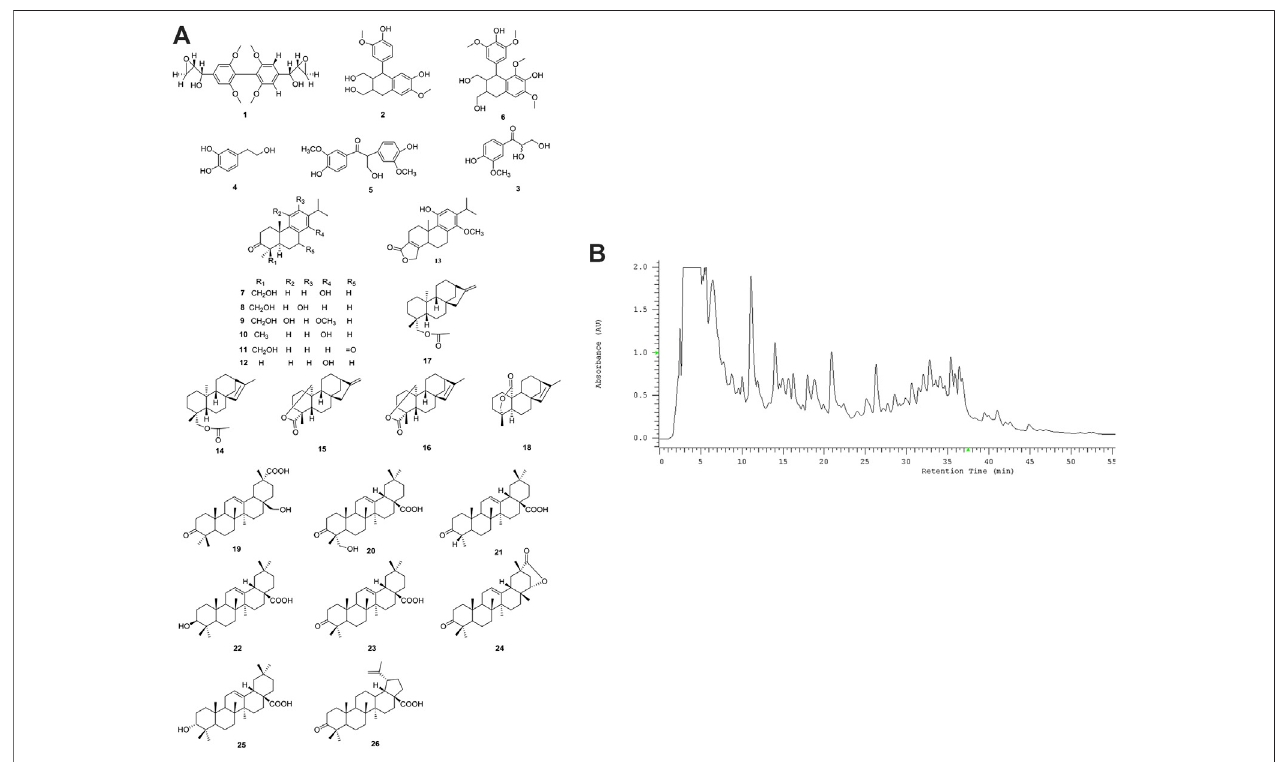
FIGURE 1 | Chemical analysis for COE. (A) Structures and names for twenty-six compounds isolated from COE. (B) HPLC DAD chromatogram of COE.